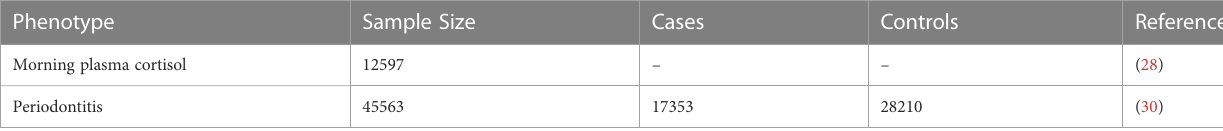
TABLE 2 Genome-wide association studies used for Mendelian randomization